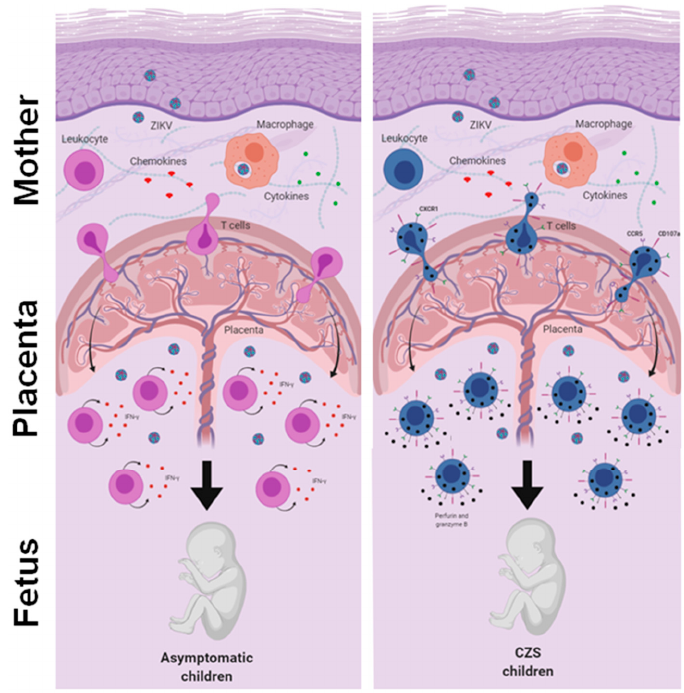
Figure 5. An integrative view of the fetal-placental anti-ZIKV immune response and the maternal immune system. The immune system in pregnancy is characterized by a reinforced network and repair to maintain the well-being of the mother and fetus. Although viral infections are common in pregnancy, transplacental passage and fetal infection are an exception. Here, we compare the reactivity of T cells to ZIKV peptides in recovery mothers infected with ZIKV during pregnancy. The child’s clinical outcome (that is, born with or without CZS) was considered the variable. We observed a trend toward high responses of IFN- γ producing T cells in mothers who had asymptomatic children and a higher expression of CD107a in T cells in mothers who had children with CZS. In addition, we found a higher frequency of CD107a+ expressing T cells and co-expressing CX3CR1+ CCR5+, which was much clearer in the T cells of mothers who had children with CZS. We suggest that this differential profile influenced the clinical outcome of babies, although these data need to be further investigated. Supplementary Materials: The following are available online at www.mdpi.com/xxx/s1, Table S1: Antibodies used in BD FACS ARIA IIu flow cytometer.